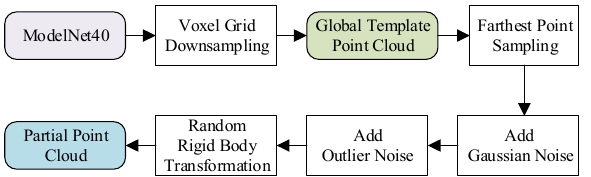
Figure 6. The creation process of a template point cloud and a partial point cloud. For each original point cloud in ModelNet40, the global template point cloud was obtained through voxel grid downsampling [46,47], consisting of 1024 data points.